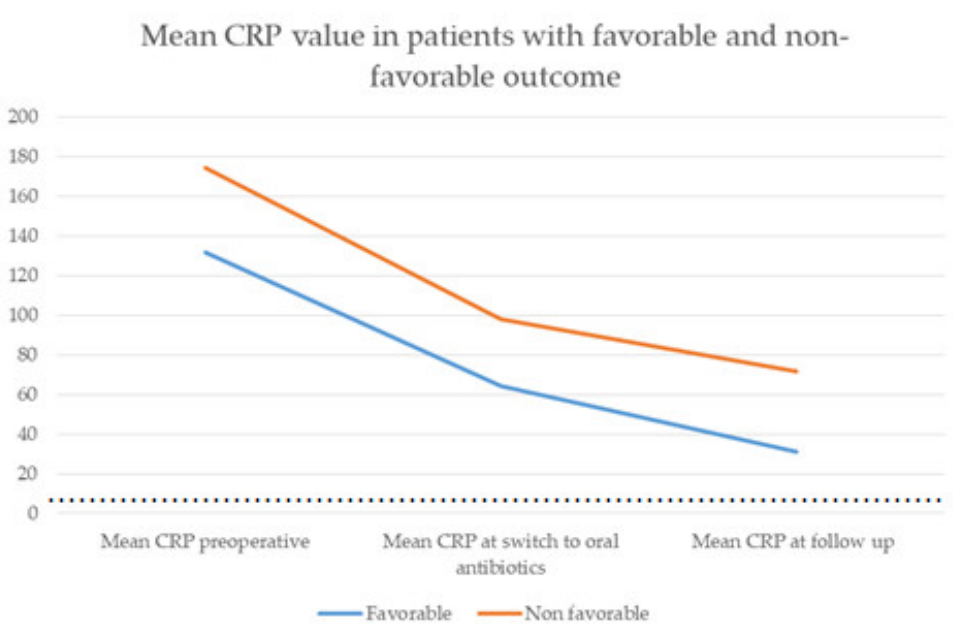
Figure 4. Mean CRP value in patients with favorable and non-favorable outcome. Graph shows course of CRP-value in patients with favorable (blue line) and no- favorable outcome (orange line). Threshold of CRP value of 5 mg/L, which is considered to be physiologic, is presented with dotted line. Patients with unfavorable outcome had higher initial CRP values and higher values of CRP at the time of switch to oral antibiotics, compared to the patients with favorable outcome.